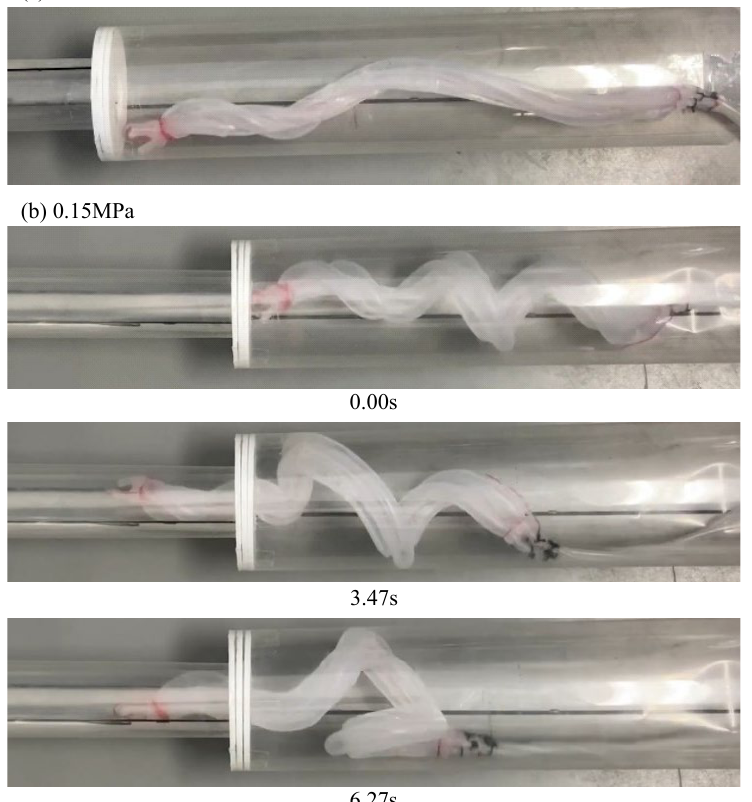
Figure 15. Experiment using a biased pitch device in a horizontally fixed pipe with the same diameter as that of the 50A and 20A pipes. ( a , b ) depict the device driven by an air pressure of 0.10 MPa and 0.15 MPa,